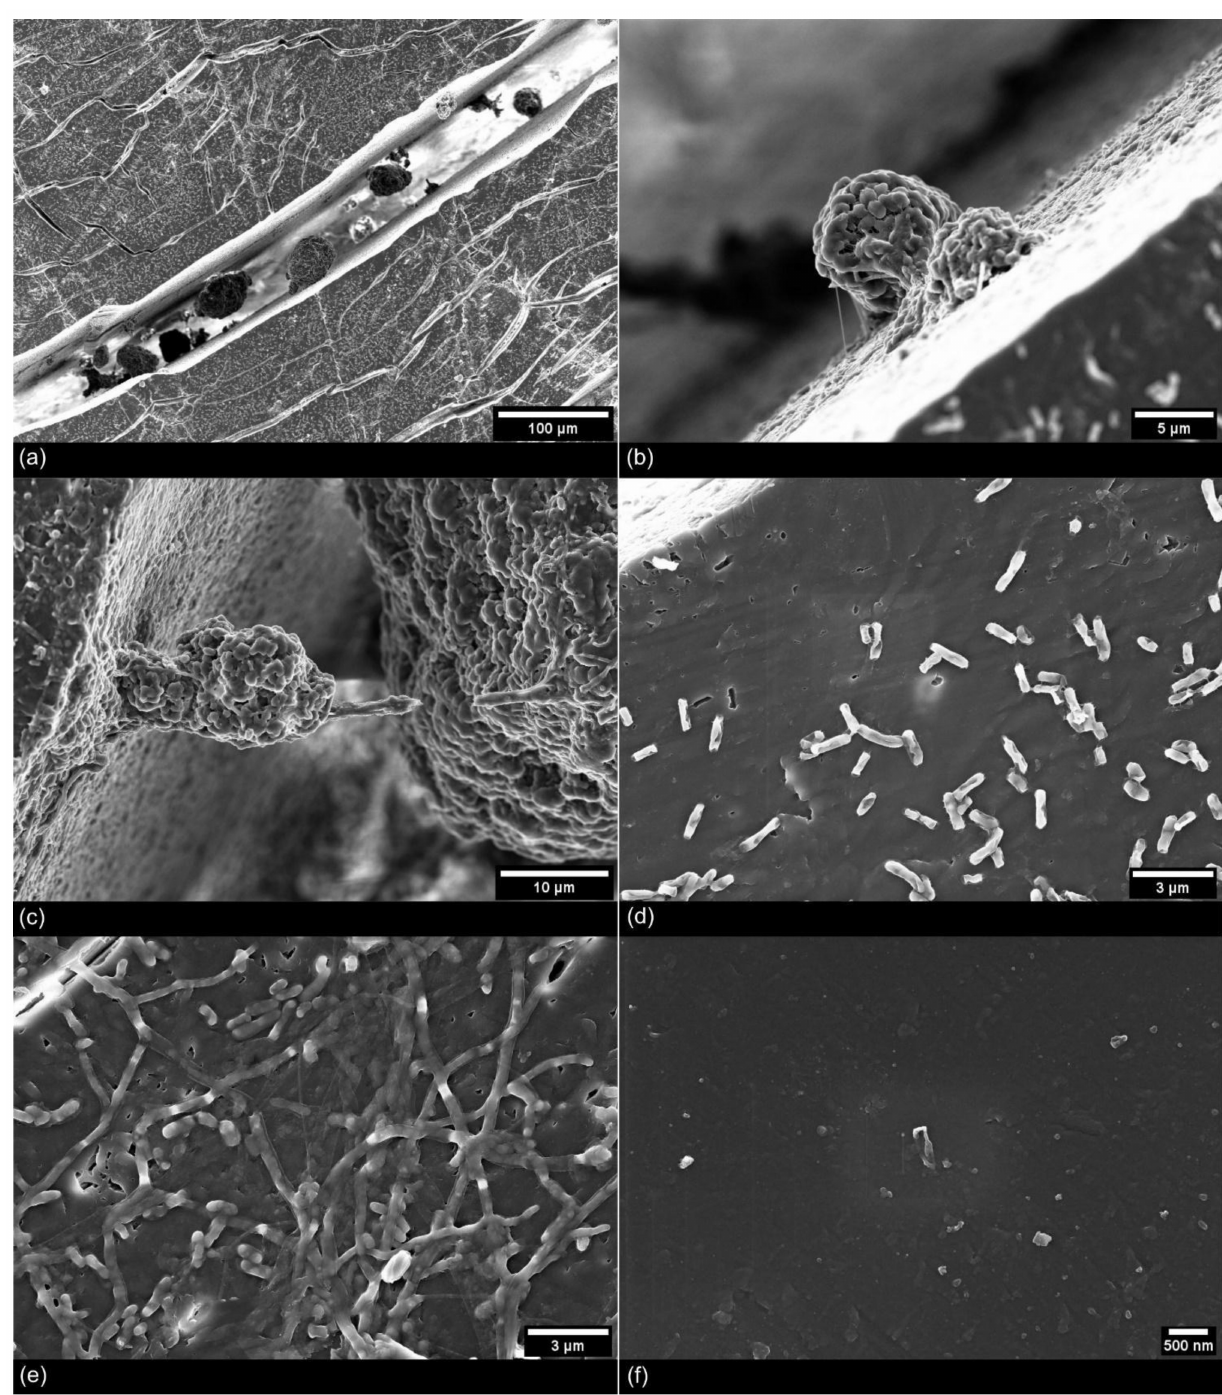
Figure 8. FESEM images of mixed microbial biofilms on PE chips after 102 days of incubation. ( a – c ) Rounded aggregates of bacterial cells were found inside the surface cracks and tightly attached with strings of EPS matrix. ( d ) Singular rod-shaped bacteria attached to the surface, adjacent holes resembled bacterial contours. ( e ) Bacterial cells attached to the surface in a network-like structure. ( f ) Untreated PE chips with poor bacterial cell attachment after